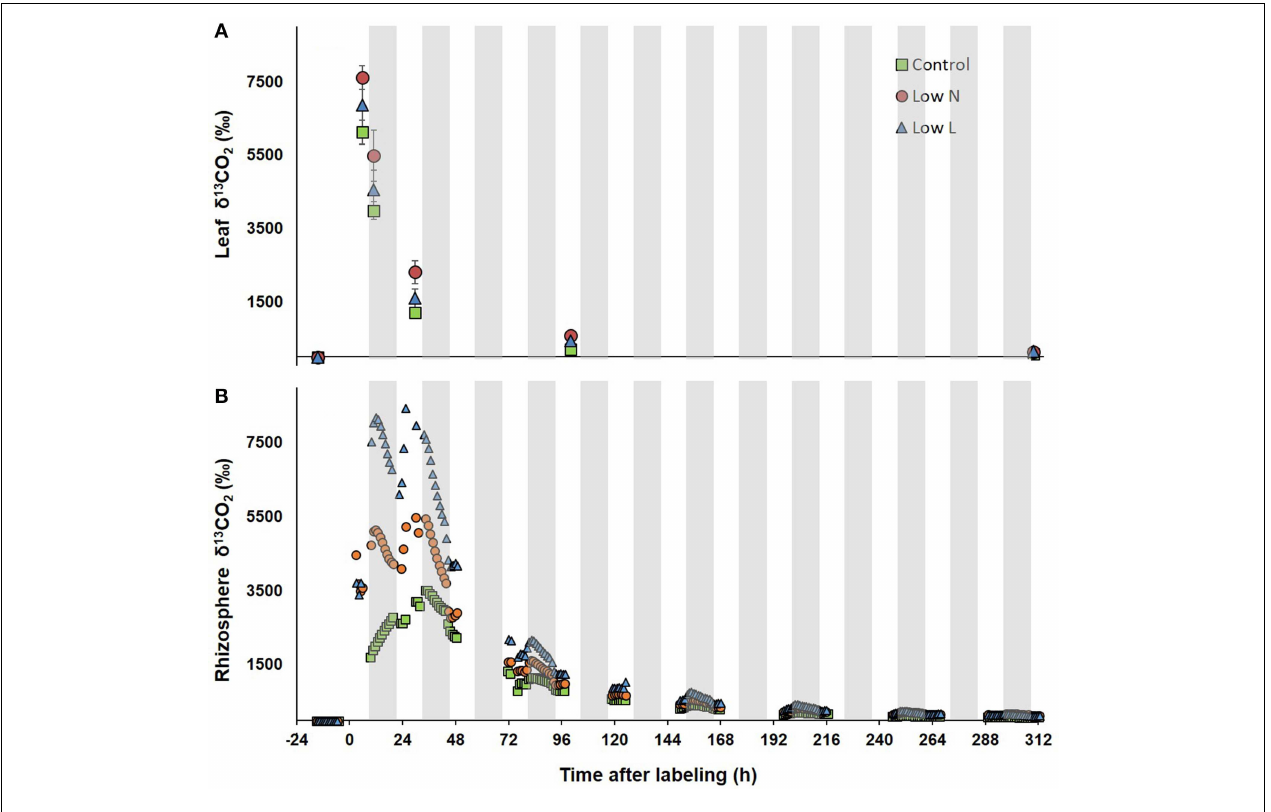
FIGURE 3 | δ 13 CO 2 of leaves (A) and rhizosphere (B) during the chase period after pulse labeling. δ 13 C of leaf respiration ( n = 3 ± SE, after day 3 n = 2 ) was measured via in-tube incubation technique (Werner et al.,